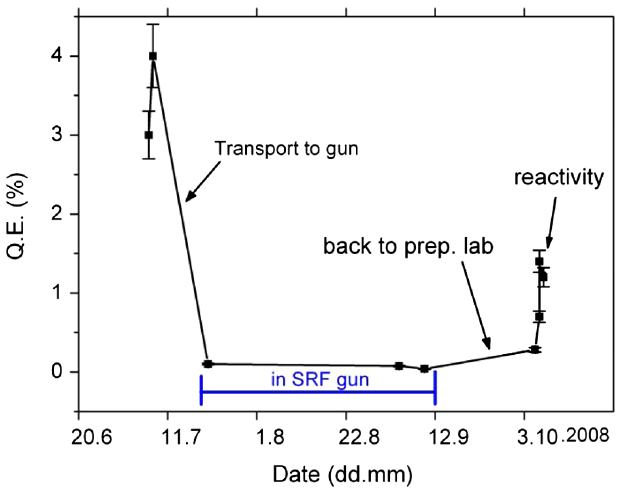
FIG. 5. (Color) History of the cathode #070708Mo. The range from July 21, 2008 to September 12, 2008 is the serving period in the SRF gun.